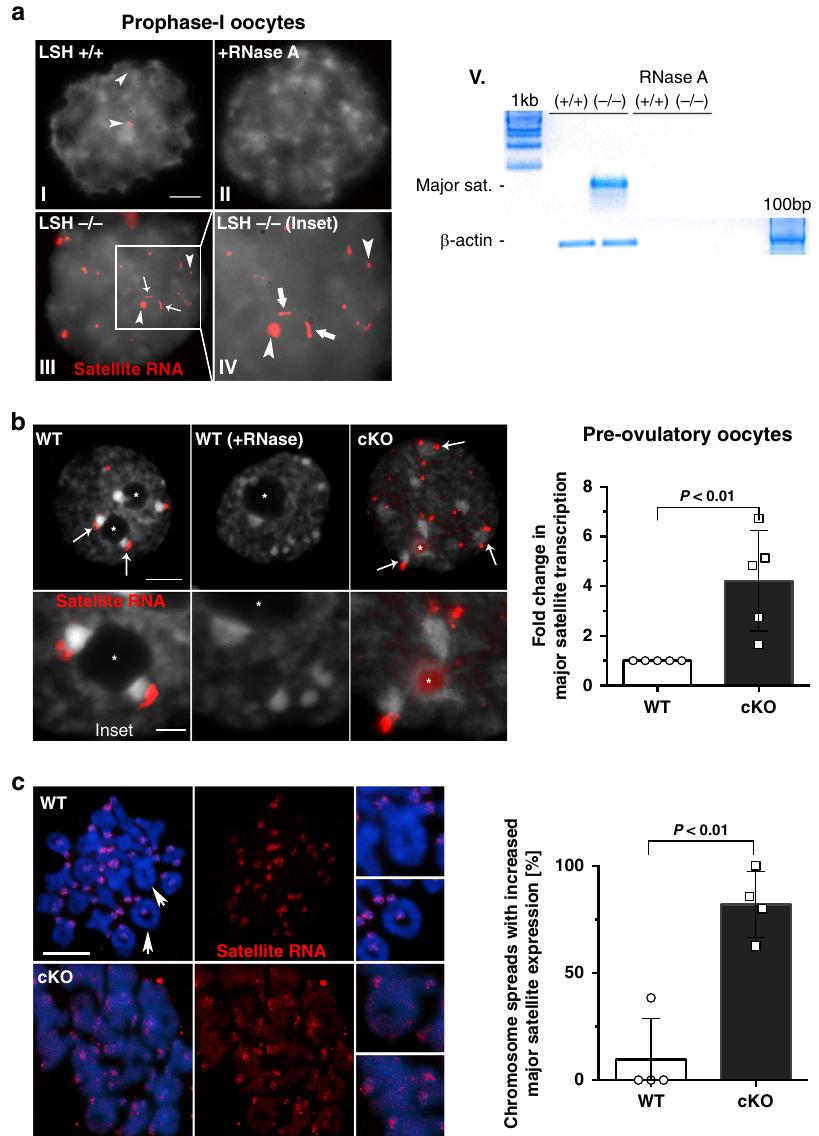
Fig. 7 LSH conditional knockout induces overexpression of centromeric noncoding RNAs. a LSH is required for the epigenetic silencing of major satellite transcripts at key stages of oocyte meiosis. I RNA-FISH in wild-type oocytes indicates that major satellite transcripts (red; arrowheads) are expressed, albeit at low levels, and remain chromatin bound during meiotic prophase-I. II No signal was detected in the negative controls after exposure of oocyte nuclei to RNase A, con fi rming the presence of single stranded RNA. However, LSH ( − / − ) oocytes exhibit a striking overexpression of centromeric noncoding RNAs. III, IV In situ detection of centromeric transcripts by RNA-FISH in mutant oocytes revealed the formation of tracks of chromatin bound centromeric RNA (arrows) as well as foci of different size (arrowheads). Scale bar (5 μ m). V Major satellite transcripts are undetectable by qPCR in the fetal ovaries of wild-type littermates. Notably, they are overexpressed in LSH mutant littermates on day E17.5. b Major satellite transcripts (red) accumulate and remain associated with the large chromocenters (arrows) of wild-type preovulatory oocytes that exhibit the non-surrounded nucleolus con fi guration (inset). No signal was detected after the treatment of oocyte nuclei with RNAse. Notably, the loss of LSH function results in overexpression of centromeric transcripts and accumulation throughout the nucleoplasm as well as the nucleolus (inset). The position of the nucleolus is indicated by (*). Scale bar (10 μ m). Inset scale bar (3 μ m). Consistent with RNA-FISH, real-time PCR revealed a fourfold increase in the levels of major satellite transcripts in Lsh − / − oocytes. Data are expressed as the mean ± SD of fi ve independent experimental replicates with ( n = 50) wild-type and (n = 50) cKO oocytes per replicate. Statistical analysis was performed using unpaired t -tests, two tailed with P = 0.0073. c Major satellite transcripts (red) remain associated with pericentric heterochromatin domains of metaphase-I chromosome bivalents in wild-type oocytes. Notably, loss of LSH function results in overexpression of satellite RNA that remains associated as multiple foci in metaphase-I bivalents. Lsh -cKO oocytes exhibit a signi fi cant increase in the proportion of chromosome spreads with elevated major satellite expression. Data are expressed as the mean ± SD of four independent experimental replicates with ( n = 37) wild-type and ( n = 29) cKO oocytes per replicate. Scale bar (10 μ m). Statistical analysis was performed using unpaired t -tests, two tailed with P =